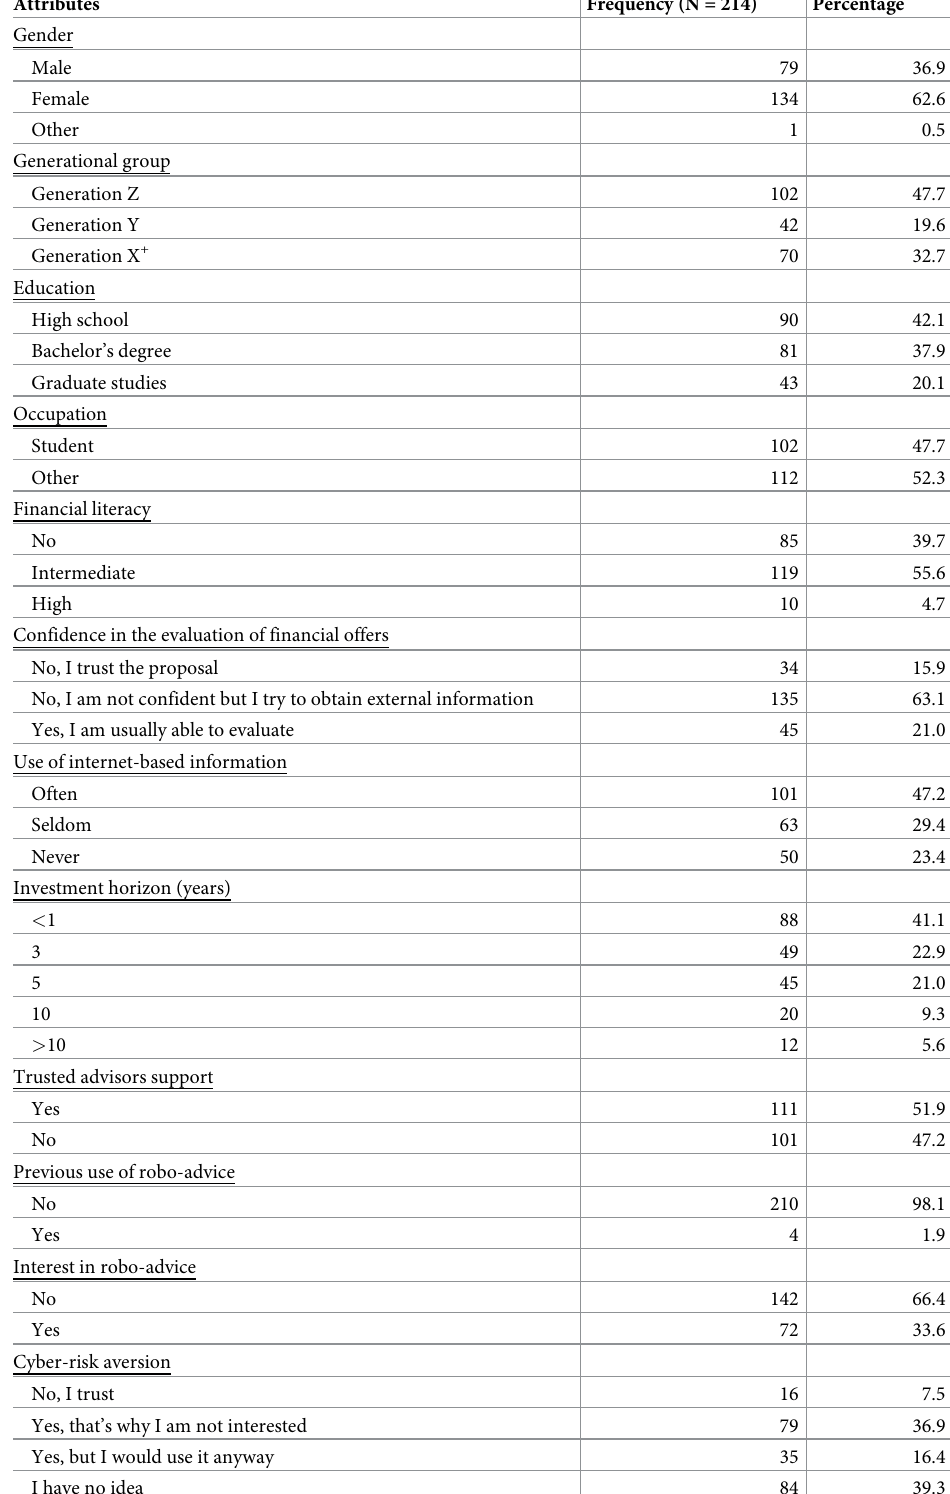
Table 2. Questionnaire: Section 1, descriptive